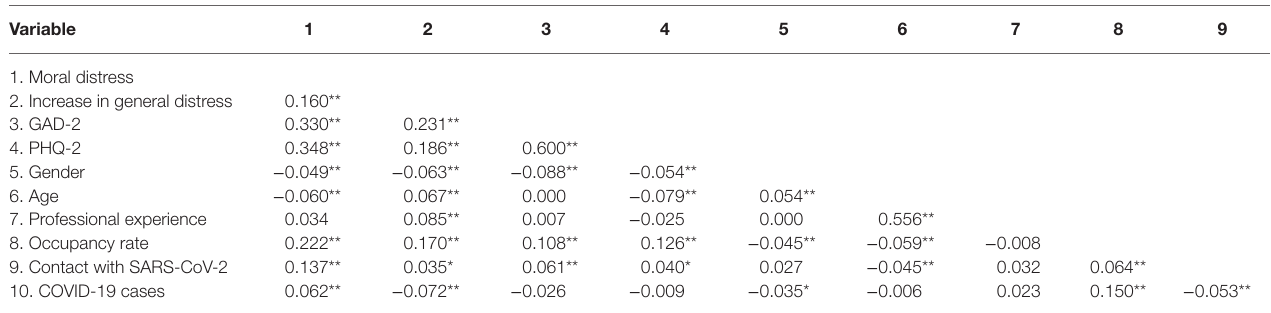
TABLE 3 | Spearman correlations for study variables.